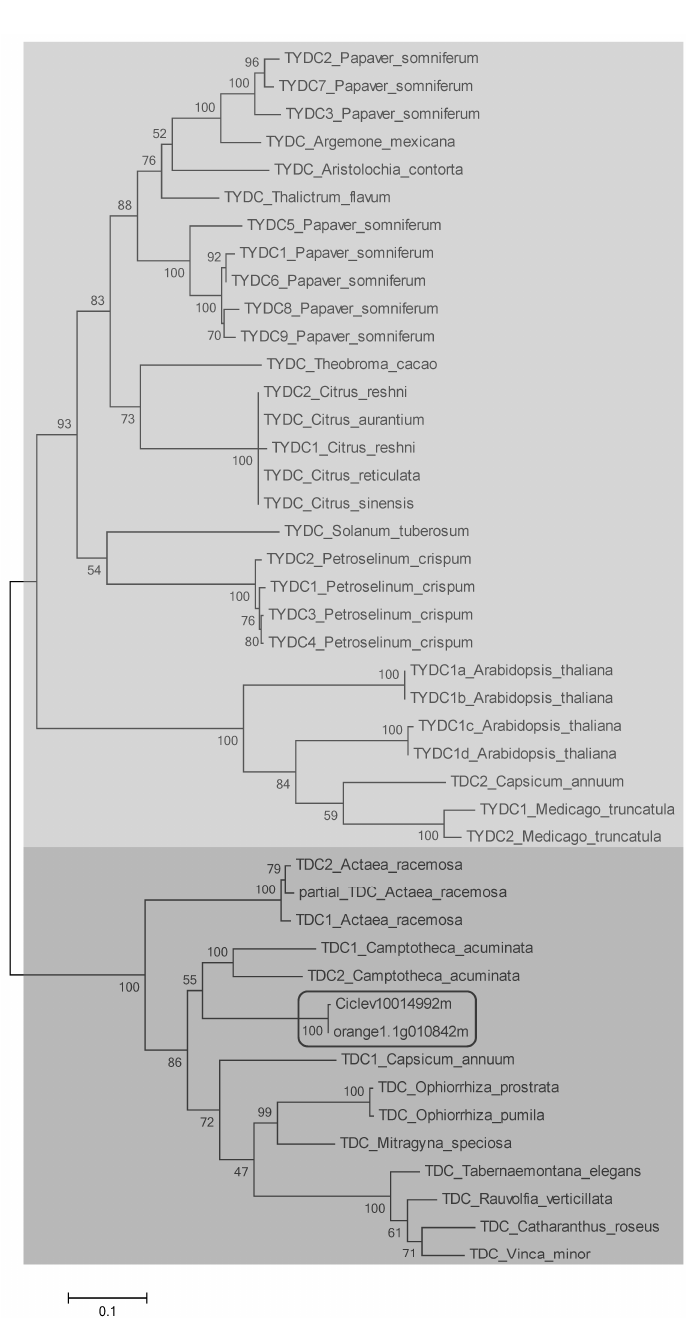
Figure 2. Relatedness among plant TDC and TYDC proteins, together with clementine and sweet orange putative sequences (pointed out), estimated by Maximum Likelihood method. The length of the lines linking the different proteins is proportional to the estimated genetic distance between the corresponding amino acid sequences. Main clusters including TYDC and TDC are distinguished.